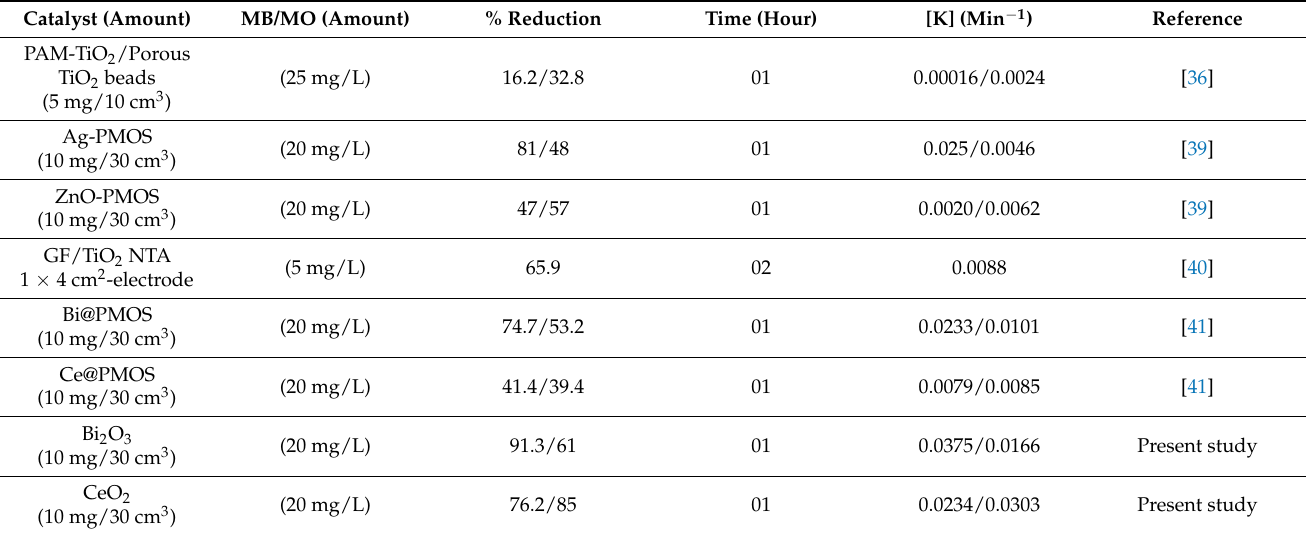
Figure 5. ( a , b ) Photoluminescence of Bi@PMOS, Ce@PMOS, Bi 2 O 3 , and CeO 2 ( c , d ) Photolumines- cence of HOPTHA produced by PTHA, Bi@PMOS, Ce@PMOS, Bi 2 O 3 , and CeO 2. Table 1. Comparison of photocatalytic efficiencies with the cited literature.